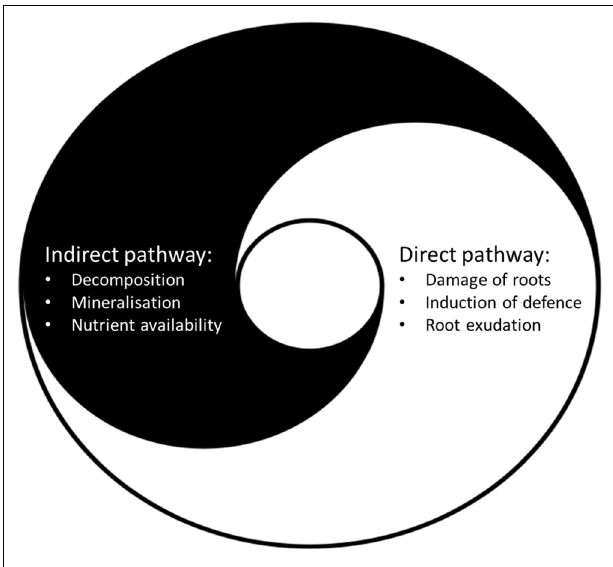
FIGURE 1 |The indirect and the direct pathway to plants are intimately linked and many soil biota affect both pathways. Soil biota in indirect interaction with roots (e.g., detritivores) enhance nutrient availability by promoting decomposition and mineralization processes (indirect pathway), but also damage roots which may lead to induction of defense and root exudation (direct pathway). Soil biota in direct trophic interaction with roots (e.g., insect root herbivores) feed and damage roots, induce defense, and change root exudation (direct pathway) which may lead to enhanced microbial activity, mineralization, and nutrient availability (indirect pathway) [image: modified from Christian Hummert